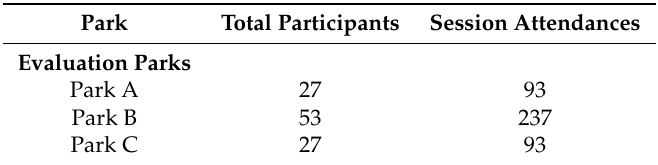
Table 3. Total Open Goals park participant numbers (May–July